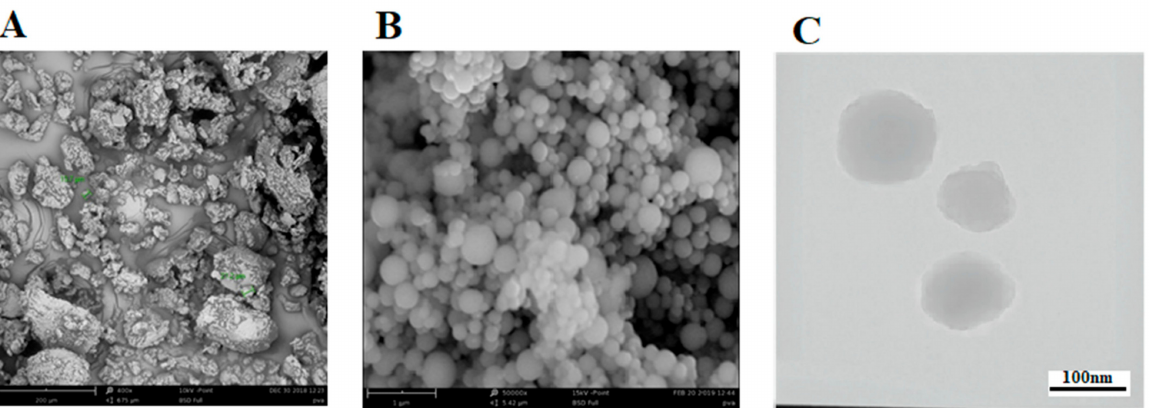
Figure 3. SEM Image of free artemether at 400 × magnification ( A ). SEM Image of encapsulated artemether at a magnification of 50,000 × ( B ). TEM image of ARM-HSA nanoparticles (lyophilized powder) ( C ). The conversion of the irregular shape of atemether into a regular, spherical shape confirms the encapsulation